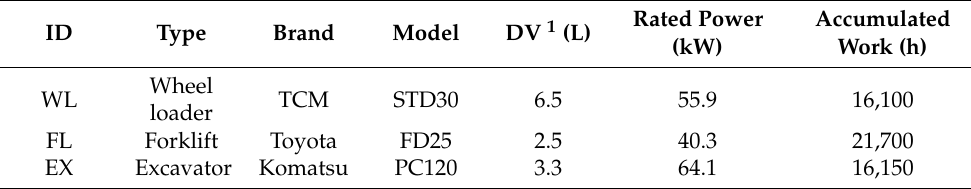
Table 1. Characteristics of test